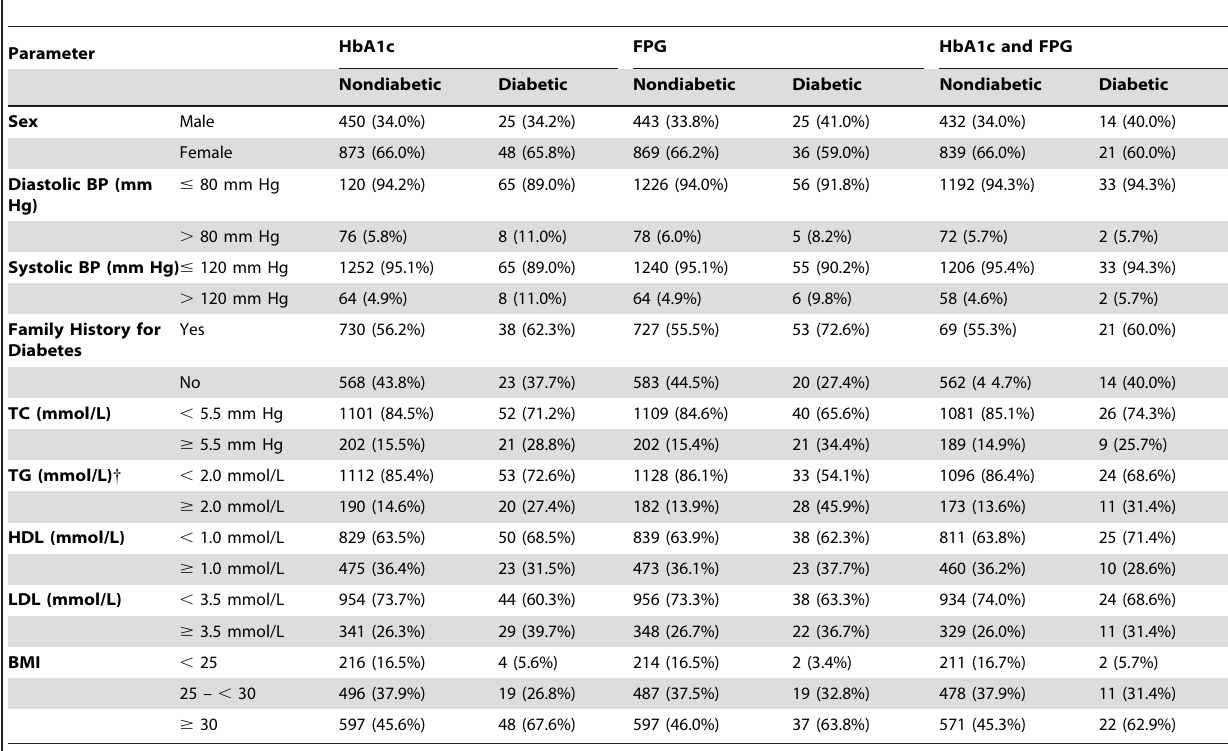
Table 3. Characteristics of individuals participating in the study according to HbA1c, FPG or both.